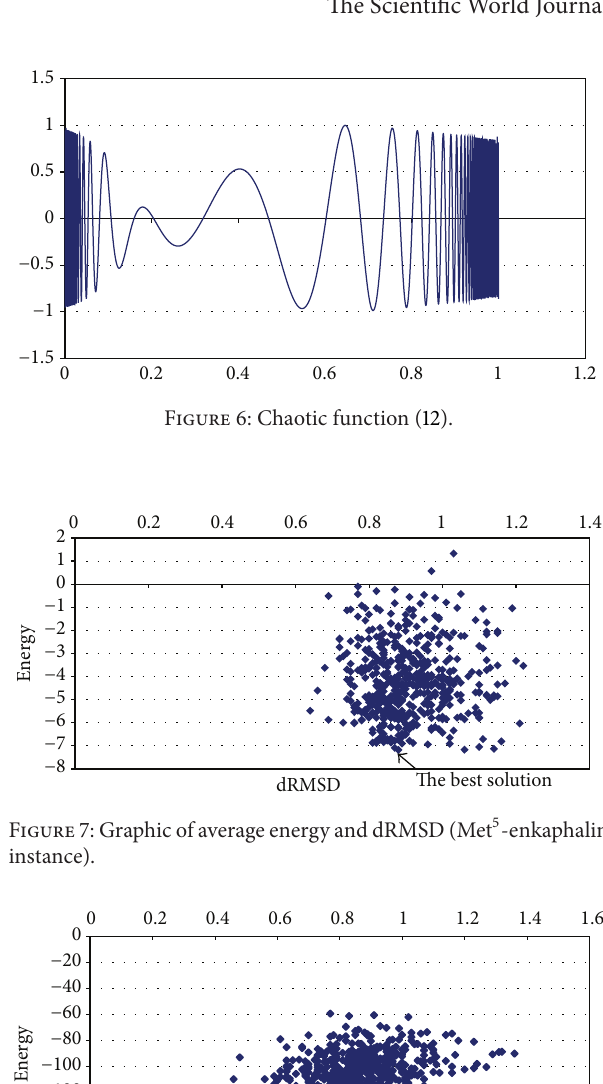
Figure 5: Chaotic function (11).